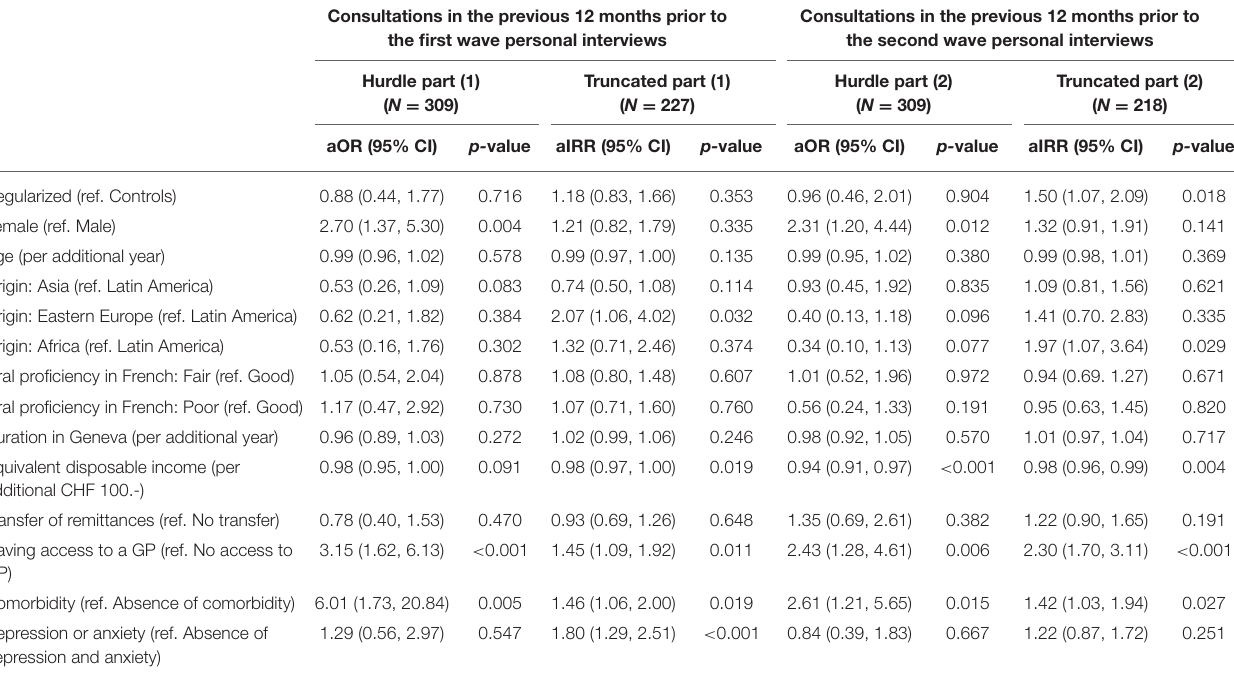
TABLE 4 | Multivariate associations between the number of consultations in the previous 12 months and predisposing, enabling and health needs factors.